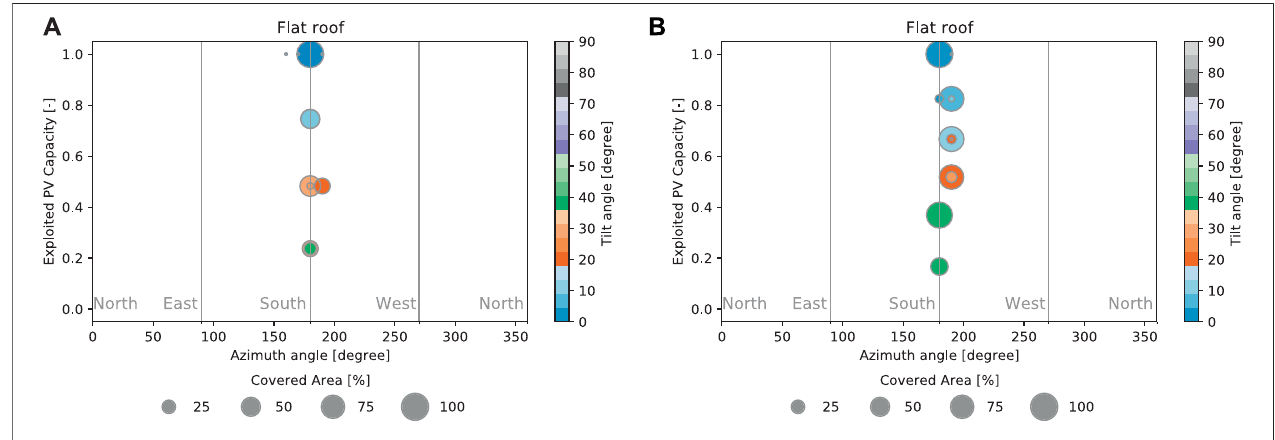
FIGURE 10 | Optimal PV orientation for different installed capacities on a fl at roof: (A) cost optimal placement for an electricity price of 0.24 CHF/kWh and feed-in tariffs of 0.08 CHF/kWh, and (B) optimal placement for self consumption for an electricity price of 0.24 CHF/kWh and feed-in tariffs of 0 CHF/kWh.